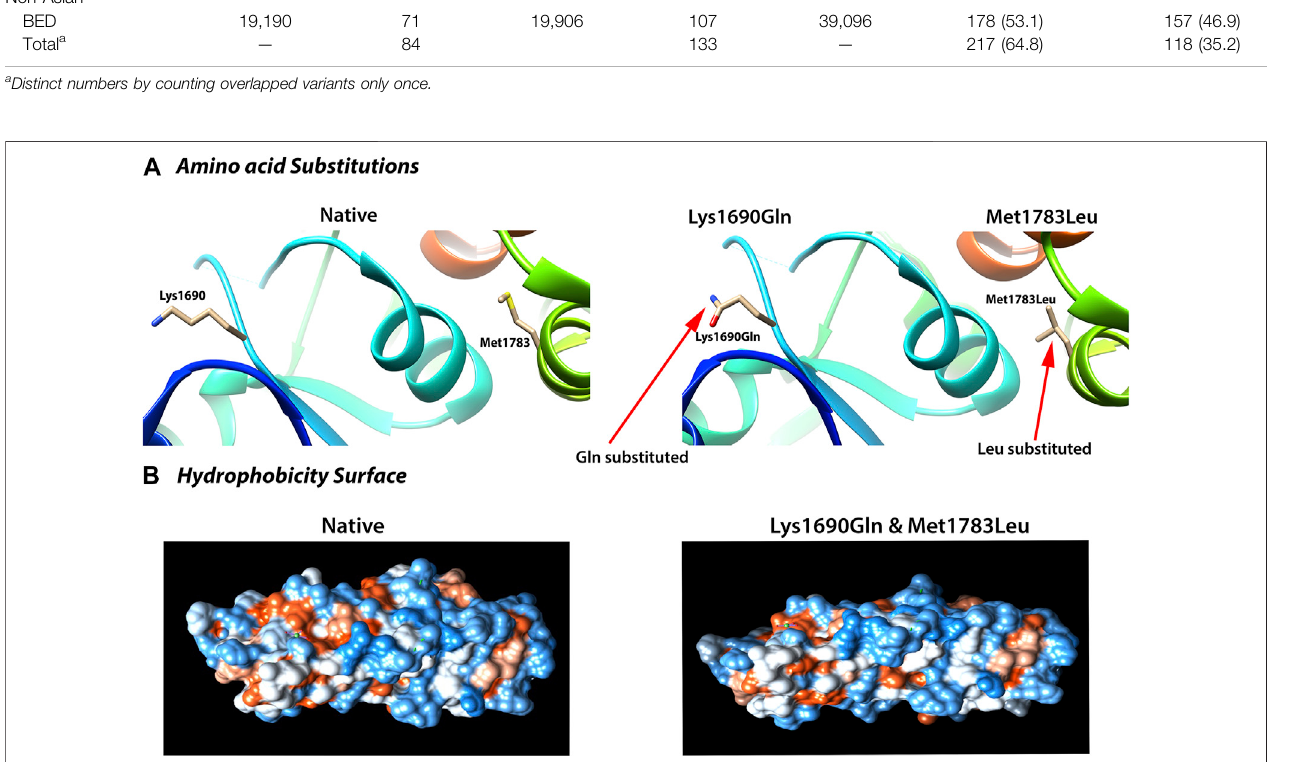
FIGURE2| Deleteriousimpactofunclassi fi edvariants(c.5068 A > C;p.Lys1690Gln;c.5347 A > C;p.Met1783Leu)onBRCA1BRCTstructuralstability. (A) Amino acid substitution showing the variant-caused amino acid change from Lys and Met (left) in the native structure to Gln and Leu (right) at the position of 1,690 and 1783, respectively. (B) Deleterious effects re fl ected by the change in hydrophobicity surface in the mutant BRCT. Both Lys1690Gln and Met1783Leu caused nearly identical change as shown here. The results were from 40 ns simulation (see text for detailed explanation).